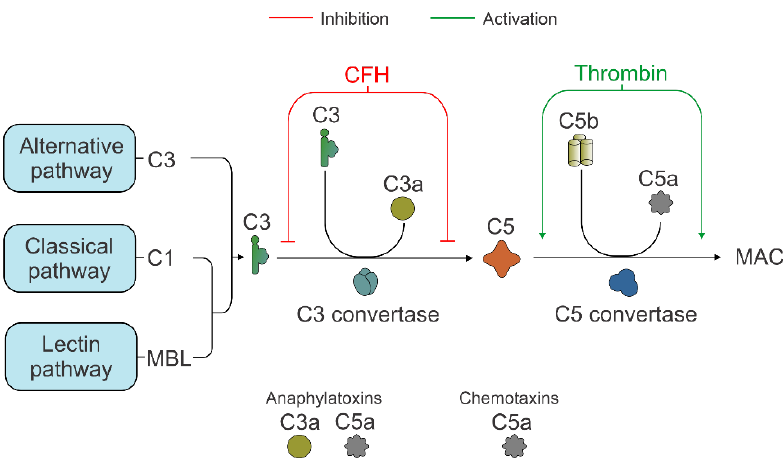
Figure 6. A schematic representation of the complement system in retina of NFE2L2/PGC-1 α dKO. Under conditions of oxidative stress and mitochondrial damage, there is a state of chronic inflam- mation involving an inhibition of component C3 via factor H (FH) and an activation of C5a and therefore of the terminal pathway; this is mediated by thrombin. However, further studies will be required to clarify the role of thrombin in chronic inflammation and AMD pathogenesis. Comple- ment components, C1, C3, C3a, C5a and C5b; MBL (mannose-binding lectin); MAC (membrane attack complex).